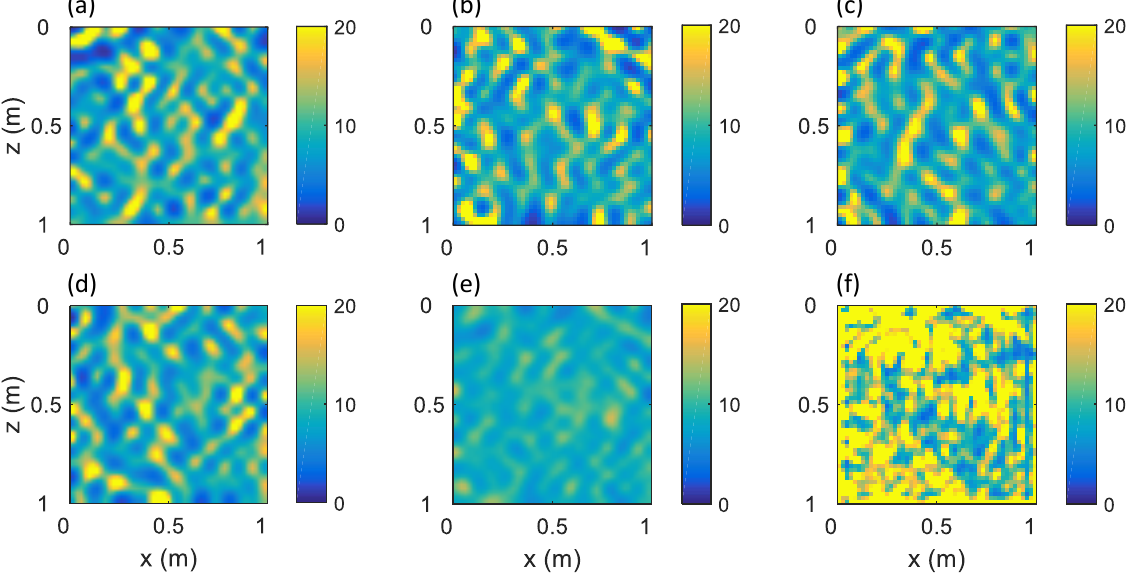
Figure 3. Posterior solutions using the straight-ray model with first-arrival traveltime data: ( a – c ) three randomly selected realizations from the posterior distribution, ( d ) the maximum a-posteriori (MAP) density solution, ( e ) the posterior mean realization, and ( f ) variance of the posterior